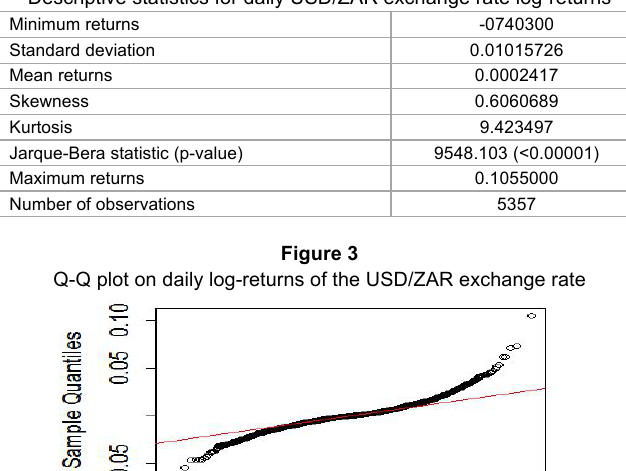
Descriptive statistics for daily USD/ZAR exchange rate